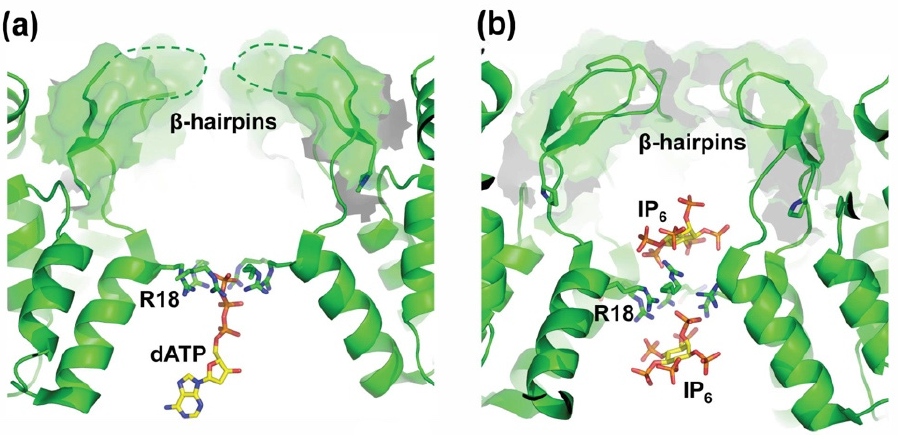
Figure 4. HIV-1 CA Residue R18 Forms a Basic Collar that Binds Translocating Nucleotide Triphos- phates and IP6. ( a ) Cross-section of the mature CA hexamer bound to dATP, highlighting how the basic R18 “arginine collar” residues (sticks) interact with the γ - and β -phosphates of a translocating nucleotide triphosphate (PDB: 5HGM). Dashed lines depict the poorly structured loop of the β -hair- pins in the closed conformation. Note that for clarity, we are showing only one of the six rotationally disordered dATP ligands. ( b ) Cross-section of the mature CA hexamer highlighting how IP6 can bind above and below the arginine collar (PDB: 6BHT). Note that for clarity, we are showing only one of each of the six rotationally disordered IP6 ligands.